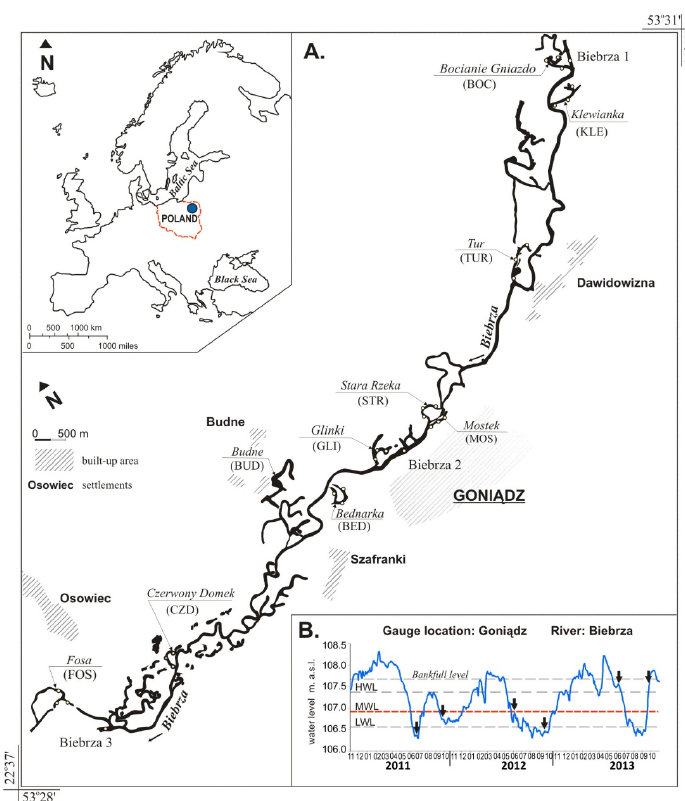
Figure 1. ( A ) Location of the study area in the Biebrza River; ( B ) Sampling events indicated by arrows on the background of hydrological situation during the period of study. Open circles indicate sampling sites located on the surveyed floodplain lakes.